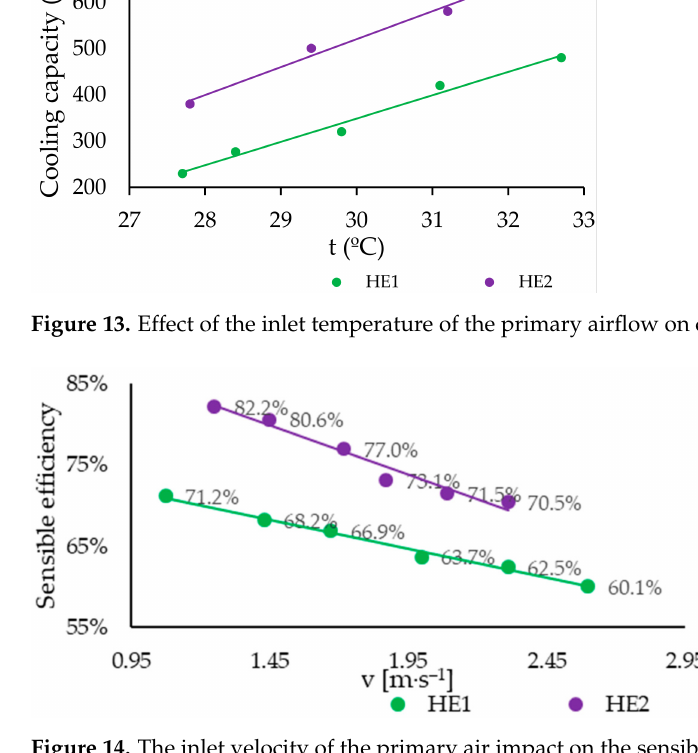
Figure 14. The inlet velocity of the primary air impact on the sensible efficiency